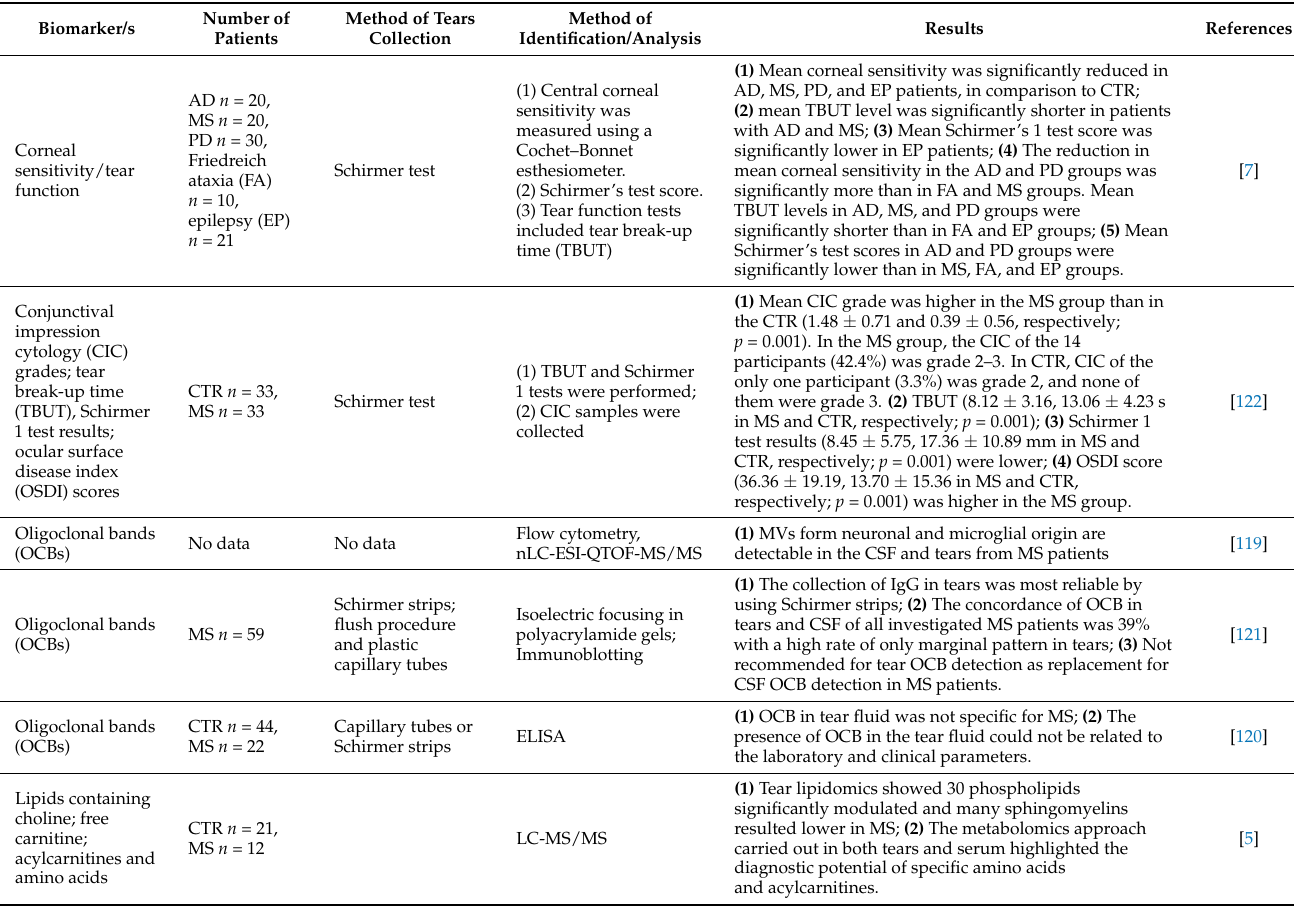
Table 4 presents the candidate biomarkers found in tears for multiple sclerosis. Table 4. Characteristic of biomarkers in multiple